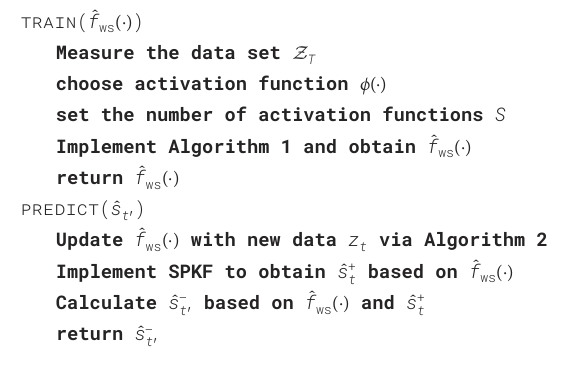
Algorithm2. AlgorithmfortheproposedELKFmethod.